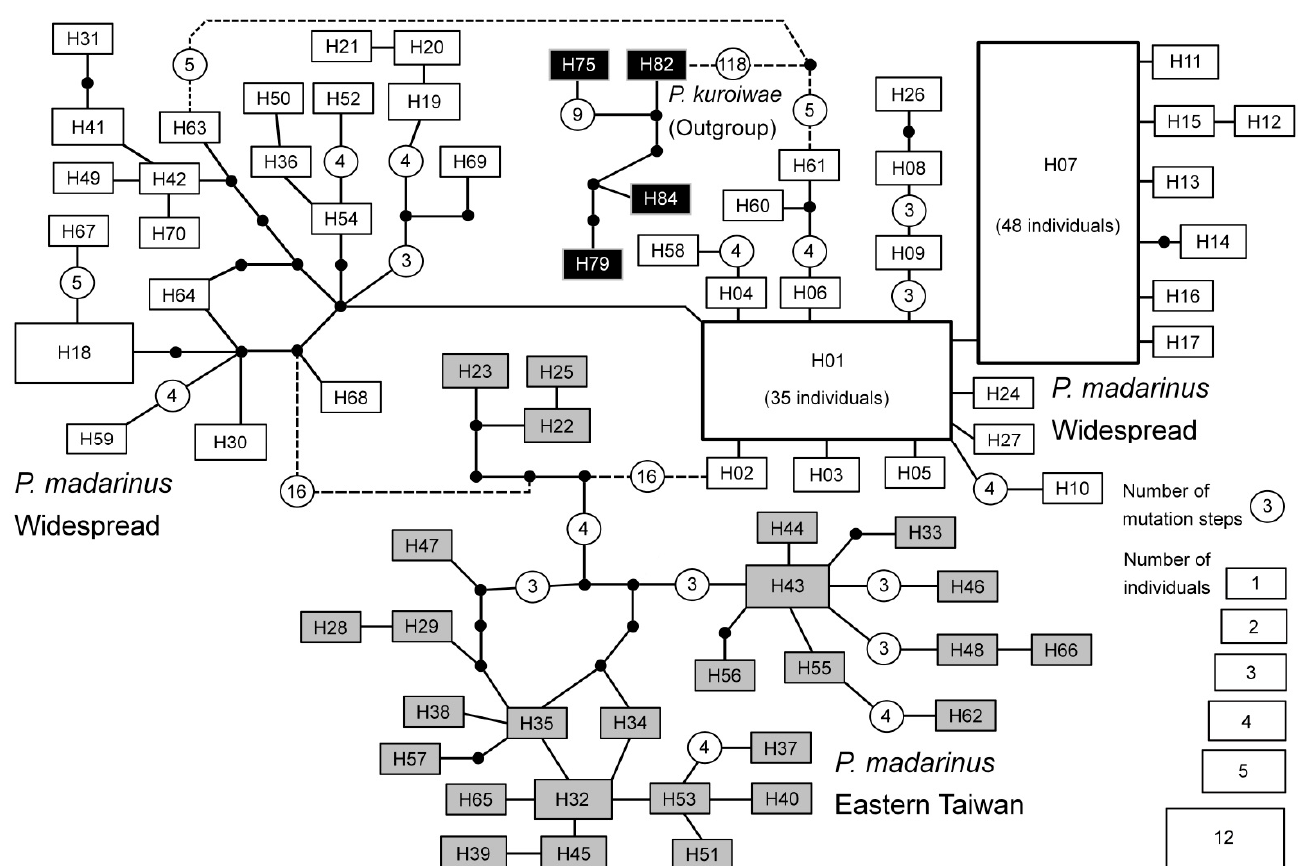
Figure 4. Statistical parsimony network of P. madarinus haplotypes. Haplotype groups that are widespread in Taiwan, endemic to eastern Taiwan or belong to P. kuroiwae (outgroup) are marked with white, grey and black rectangles, respectively. The sizes of the rectangles for each haplotype are proportional to the number of individuals found carrying each haplotype. Black dots represent hypothetical and unobserved intermediate haplotypes. Solid lines between haplotypes represent one mutational step. For haplotypes connected with more than three mutational steps, open circles with numbers are applied, indicating the number of mutational steps between haplotypes. Dashed lines represent connections between haplotypes with statistical probability < 95%.